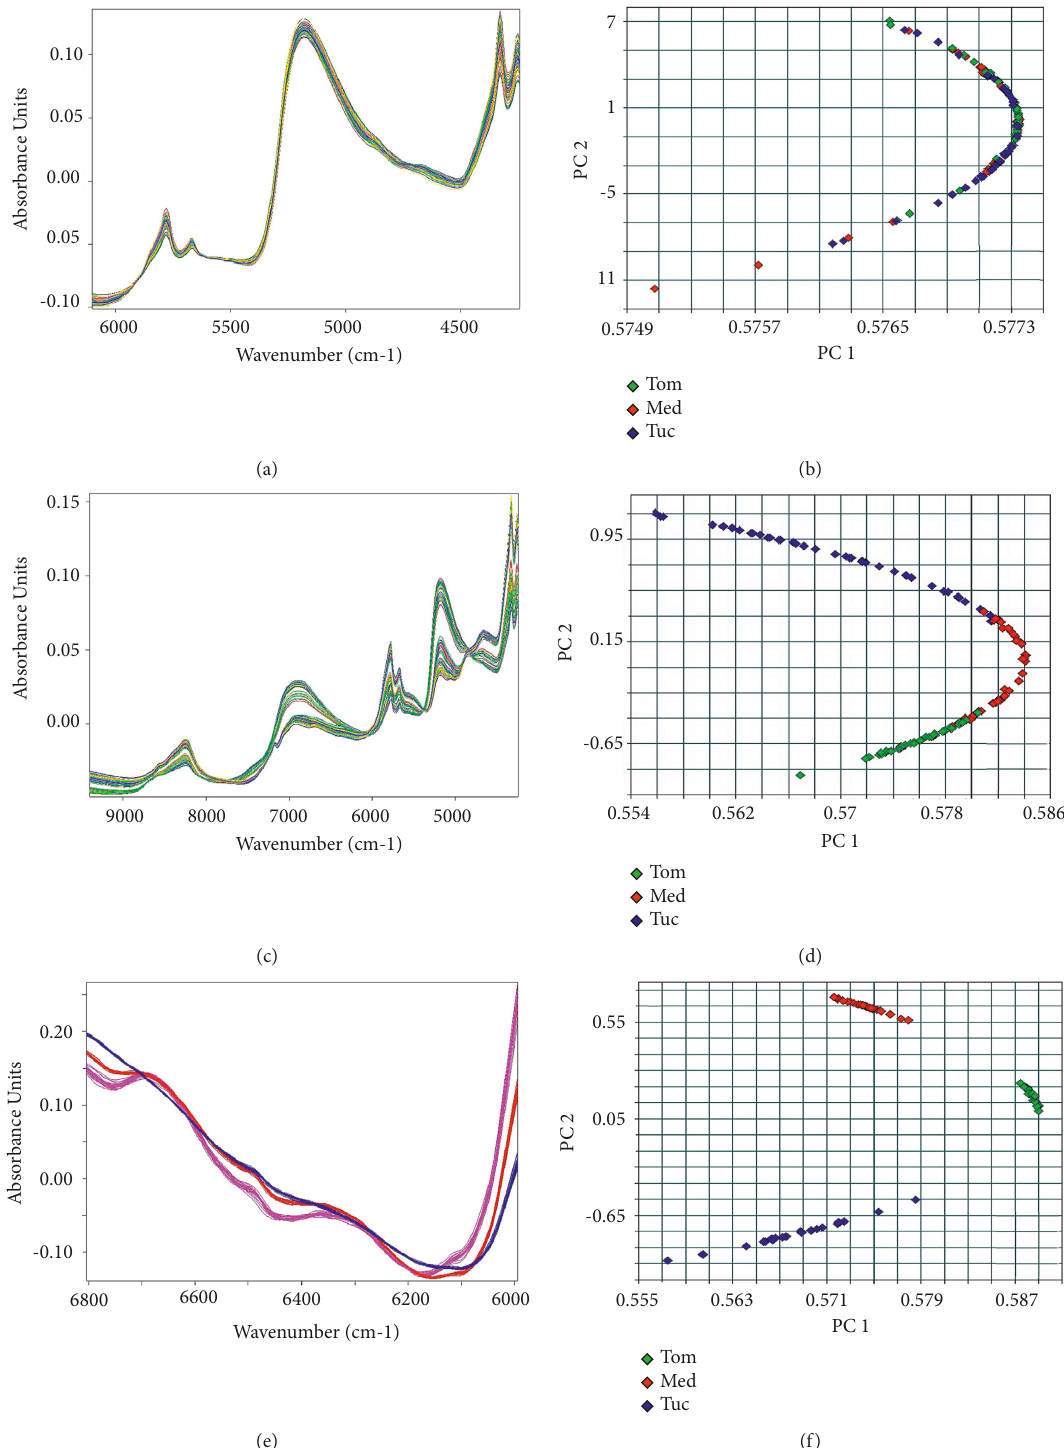
Figure 2: The absorption spectrum of the separation regions of (a) RC, (c) DU, and (e) DF, and their respective scores in the PCs graphs (b), (d), and